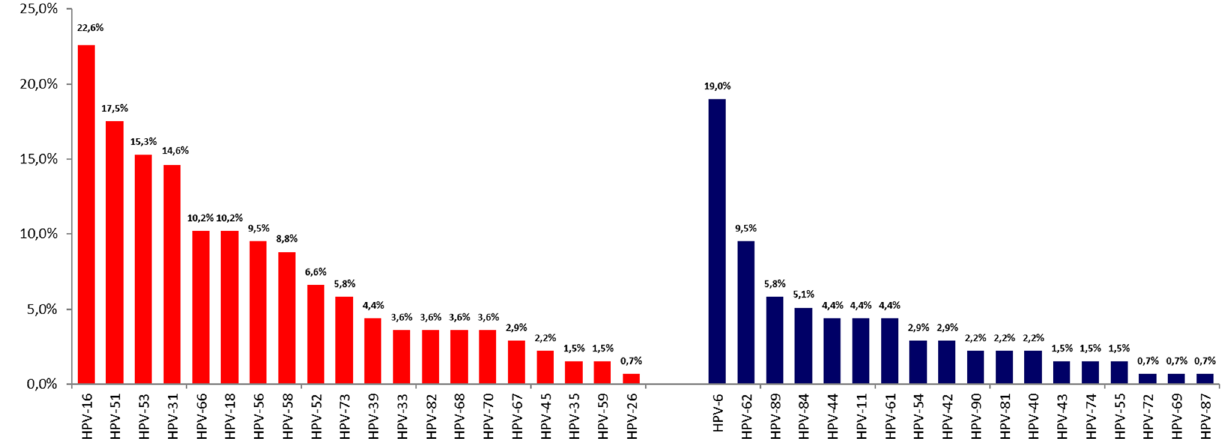
Figure 2. Type-specific distribution of hrHPV (red) and lrHPV (blue) among 137 men HPV + with a risky sexual contact (Group II).